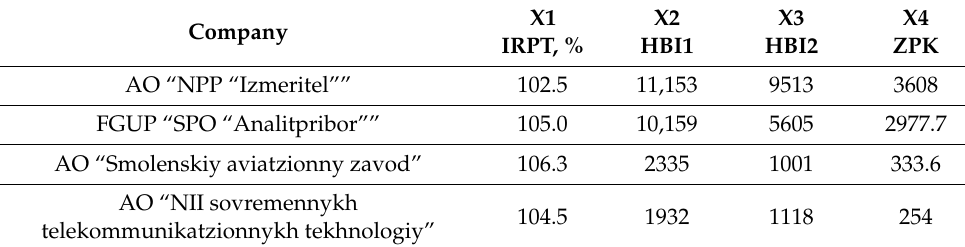
Table 4. Data on the digitalization-related costs of companies in the Smolensk region as of 2019. Company